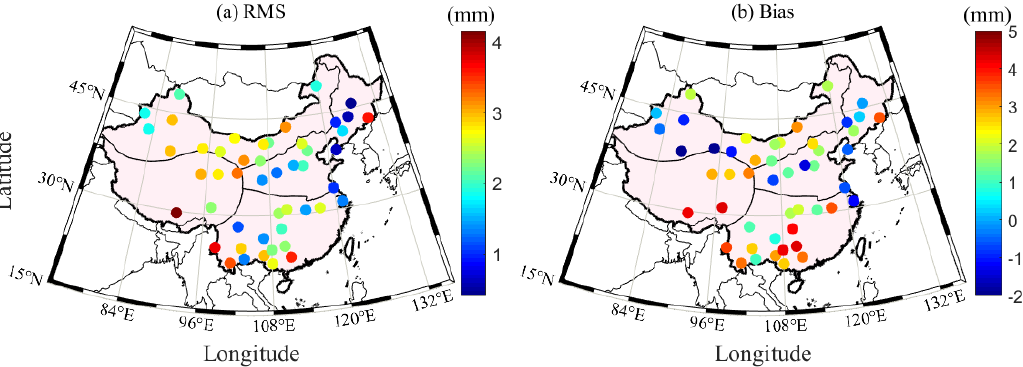
Figure 8. Time series of PWV derived from GNSS and RS at HLAR station (49.3° N, 119.7° E) during the period 2011–2017.